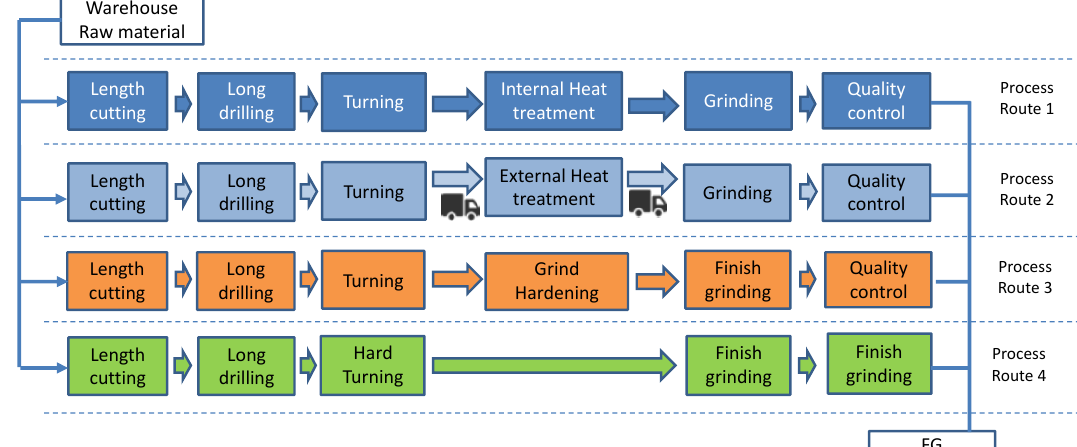
Figure 10. Validation scenario.